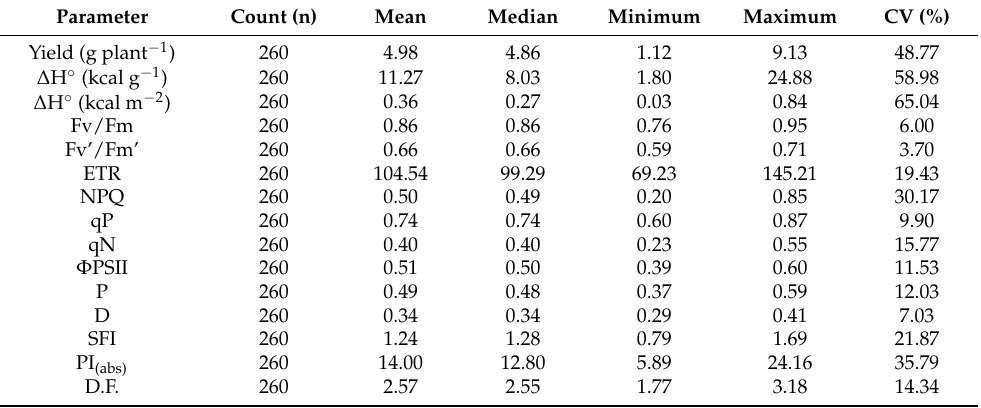
Table 1. Descriptive analysis performed in tobacco plants. Parameters: Yield, biomass of tobacco plants (g plant − 1 ); ∆ H ◦ mass (kcal g − 1 ), calorimeter energy content by mass; ∆ H ◦ area (kcal m − 2 ), calorimeter leaf energy content by area; Fv/Fm: Maximum quantum efficiency of PSII photochemistry in the dark-acclimated state; Fv’/Fm’: Maximum efficiency of PSII in light-acclimated state; ETR, electron transport rate ( µ mol m − 2 s − 1 ); NPQ, non-photochemical quenching calculated as (Fm − Fm’)/Fm’; qP: Photochemical quenching calculated as (Fm’–Fs)/(Fm’ − Fo’); qN: Non-photochemical quenching calculated as (Fm − Fm’)/(Fm − Fo’); Φ PSII, PSII operating efficiency in light conditions as calculated (1 − Fs/Fm’); P, fraction of light absorbed in PSII antennae that is utilized in PSII photochemistry; D, fraction of light absorbed in PSII antennae that is dissipated thermally; SFI, Structure function index; PI (abs) , Performance index For energy conservation photons absorbed by PSII antenna, until the reduction of PSI acceptors; D.F., Driving force on absorption light by cross-section